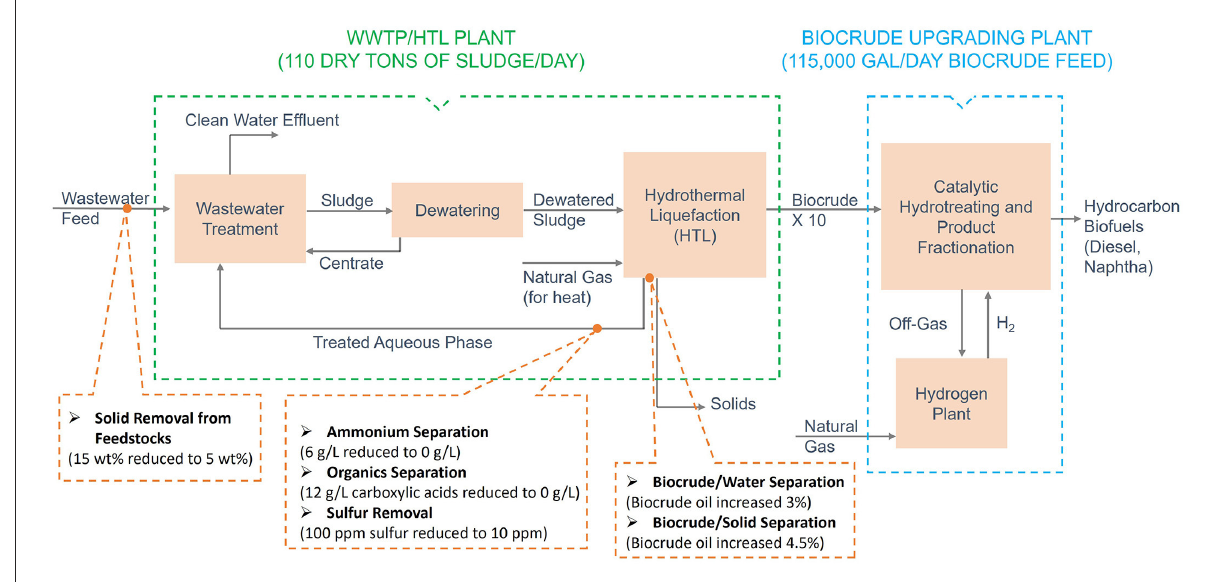
FIGURE3 Process diagram for wet-waste HTL, with the locations of the assessed separation challenge